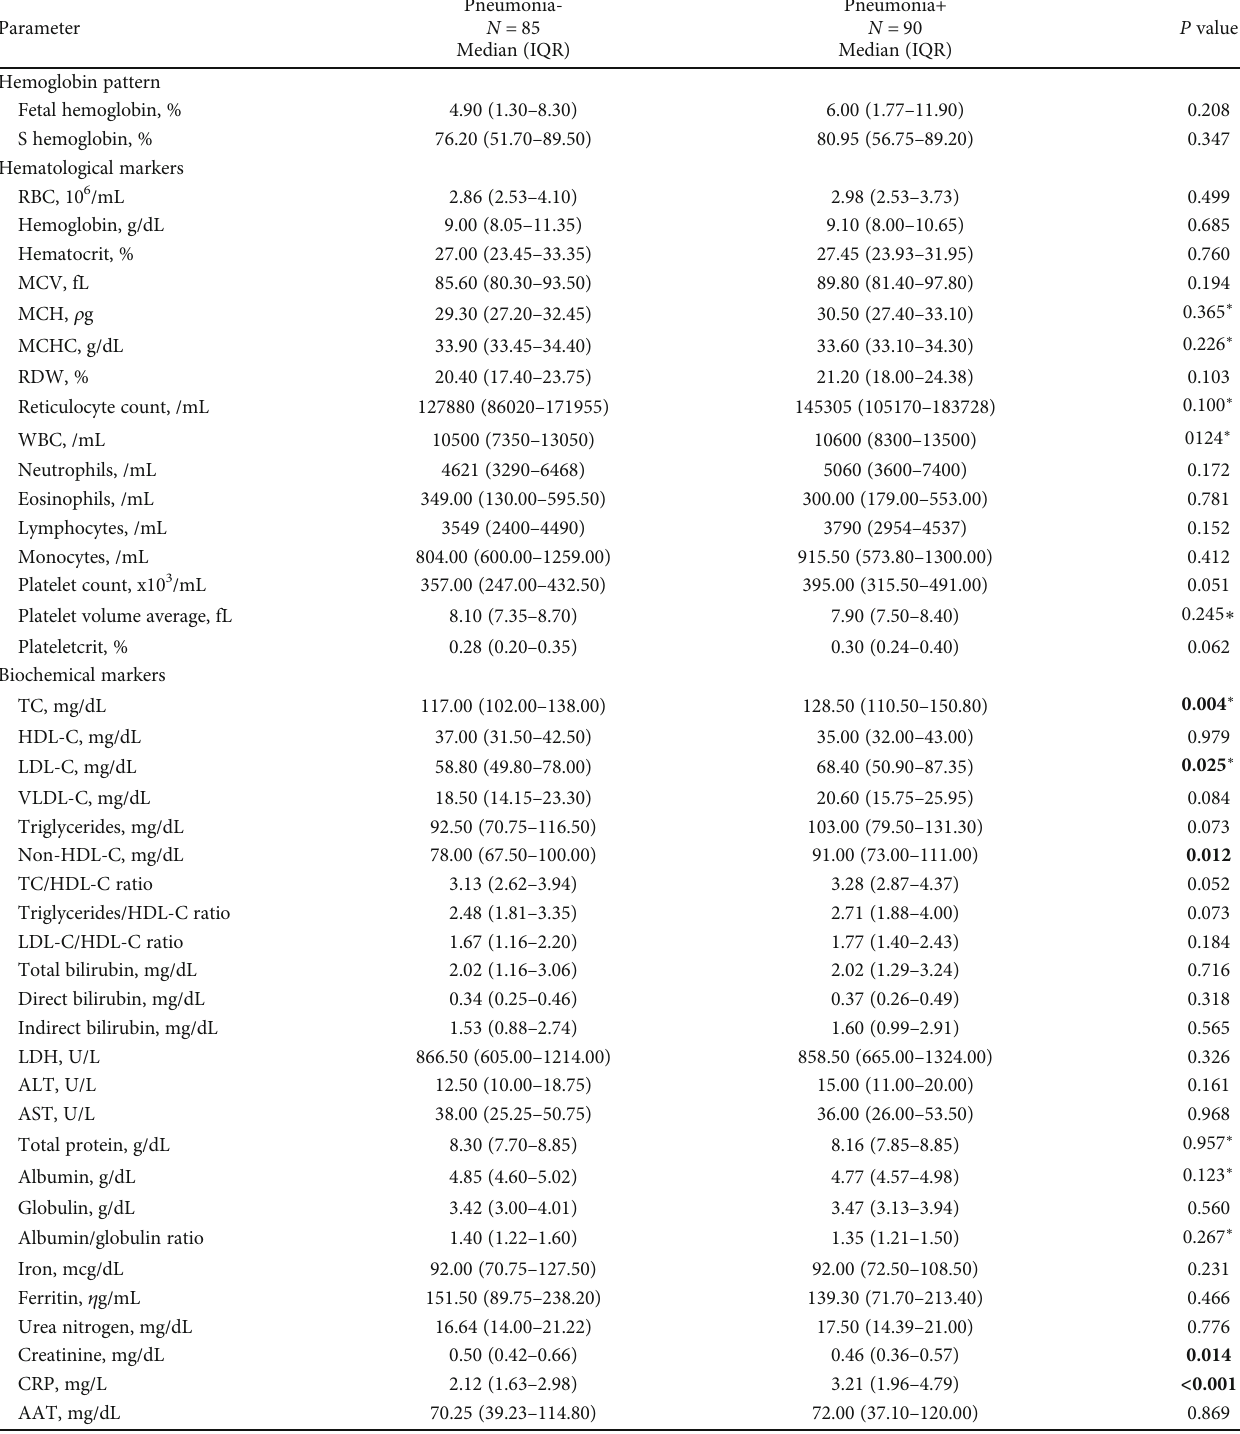
Table 8: Association of occurrence of pneumonia with laboratory